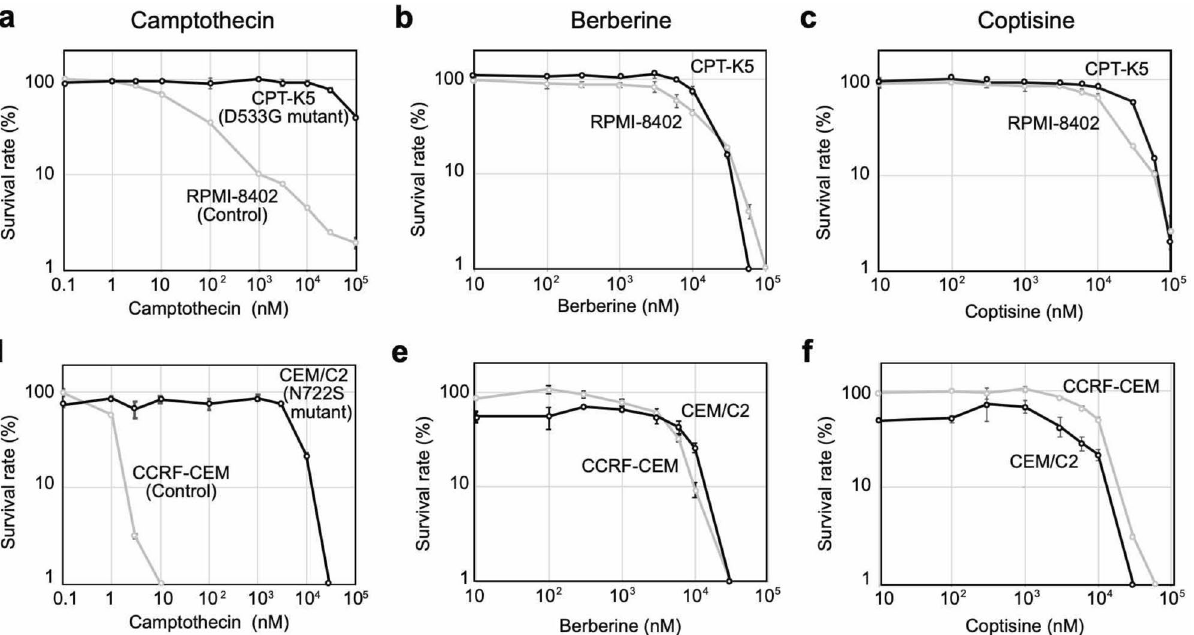
Figure 8. Analysis of the inhibitory effects of BIAs against CPT-resistant cells and Topo I proteins. ( a ) Analysis of CPT resistance of CPT-K5 cells carrying D533G mutations in the TOP1 gene. ( b,c ) Survival curve of RPMI- 8402 and CPT-K5 cells after treatment with berberine ( b ) and coptisine ( c ). ( d ) Analysis of CPT resistance of CEM/C2 cells carrying N722S mutations in the TOP1 gene. ( e,f ) Survival curve of CCRF-CEM and CEM/C2 cells after treatment with berberine ( e ) and coptisine ( f